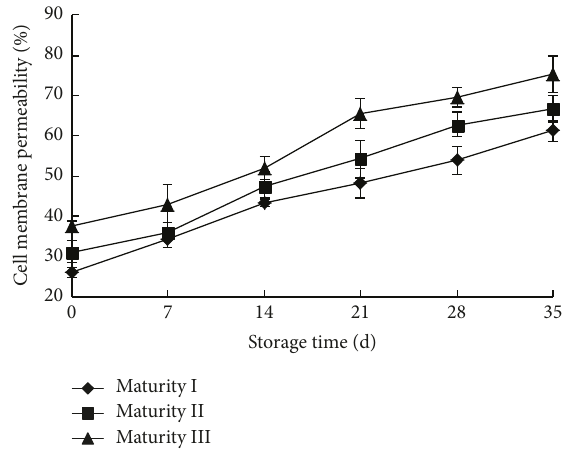
Figure 8: Effects of harvest maturity on weight loss rate in apricots; fruits with maturity class I (colored area < 50%), maturity class II (colored area 50–80%), and maturity class III (colored area > 80%) were categorized according to the yellow conversion rate. Vertical bars represent the standard errors of the means of triplicate replicates.